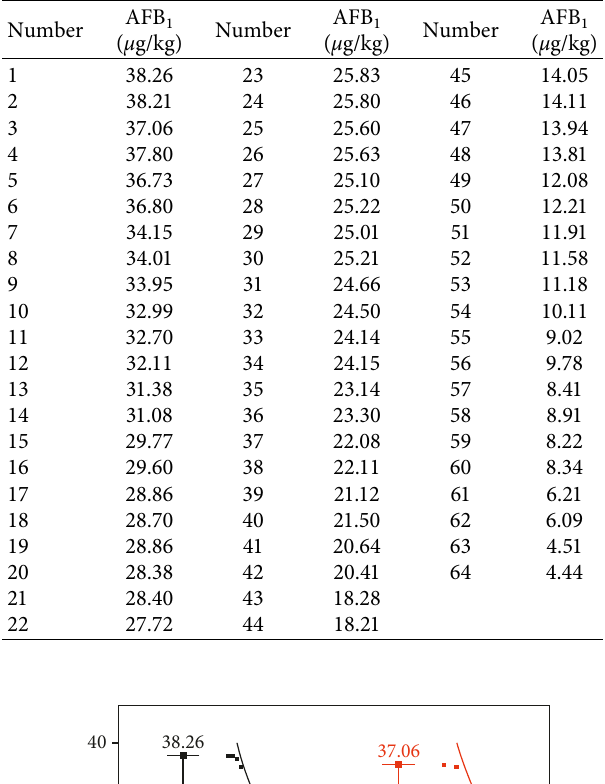
Table 1: Reference AFB 1 concentrations of the 64 positive samples.